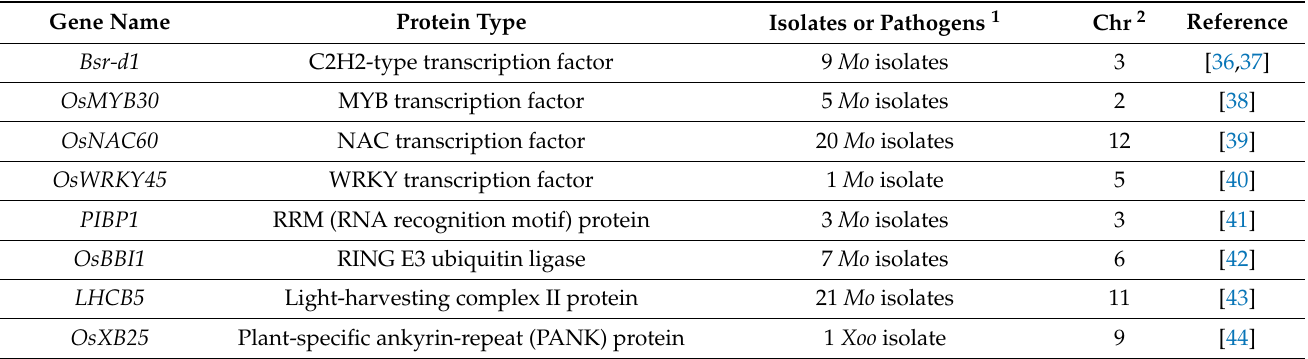
Table 2. Defense regulator genes showing broad-spectrum disease